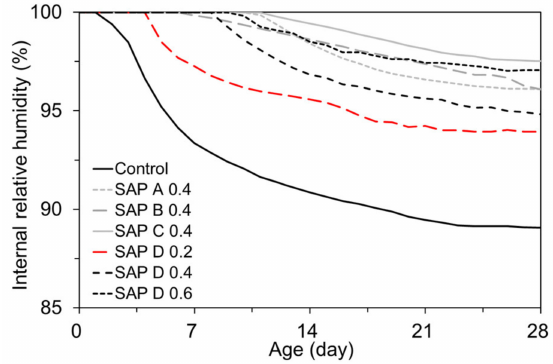
Figure 12. Effects of SAP addition on IRH